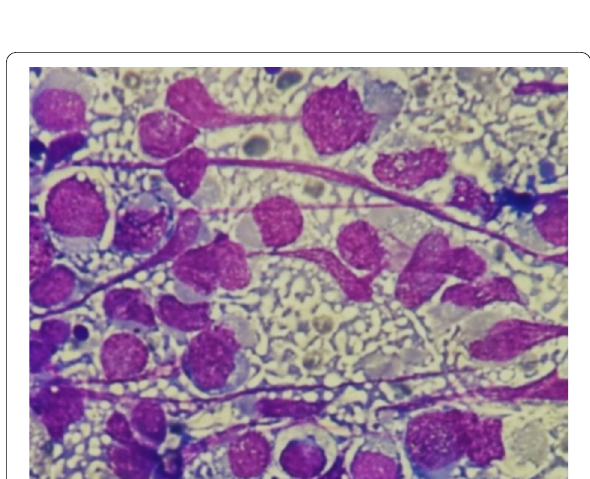
Fig. 4 Cytosmear (400X) showing dispersed neoplastic cells having large nuclei in a tigroid